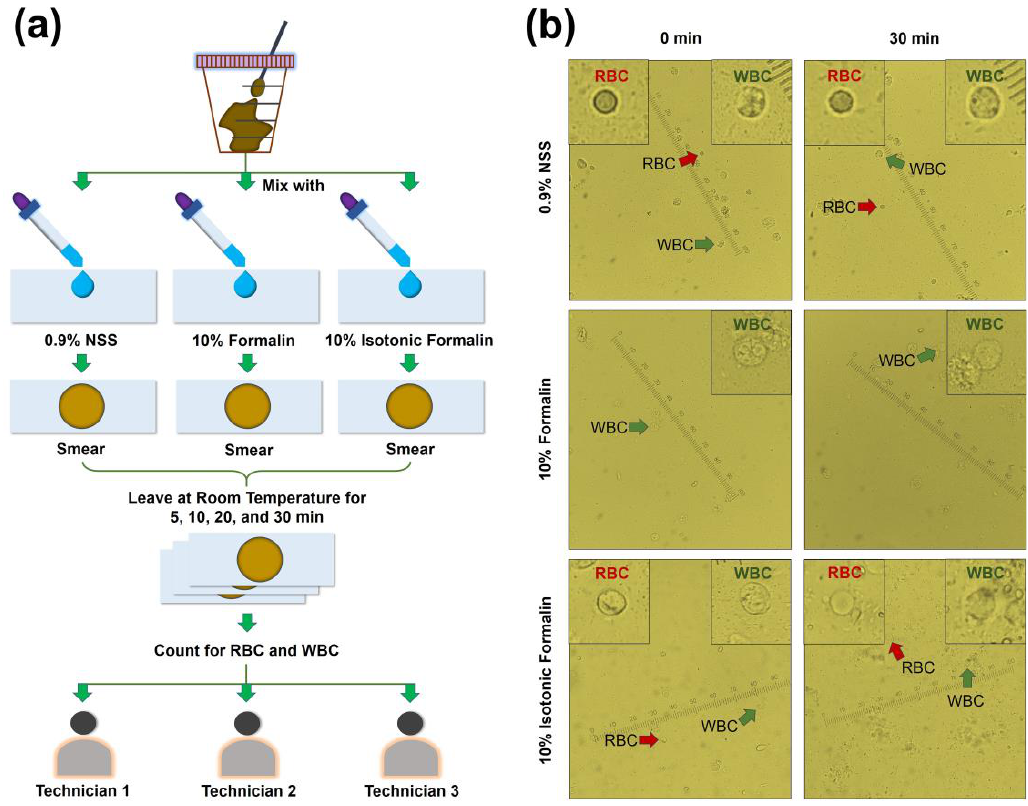
Figure 4. Stabilization of 10% formalin and 10% isotonic formalin blood cells at 0 and 30 min: ( a ) Flow diagram of fecal smear preparation and analysis of blood cells. ( b ) Persistence of red and white blood cells in fecal smears prepared with 10% formalin and 10% isotonic formalin compared to that prepared with 0.9% normal saline solution (NSS), a standard solution. One block of scale bar repre- sents 0.25 micrometers. Red arrow indicates red blood cell (RBC). Green arrow indicates white blood cell (WBC). The upper right and left corners of each figure display zoomed-in images of white and red blood cells, respectively.